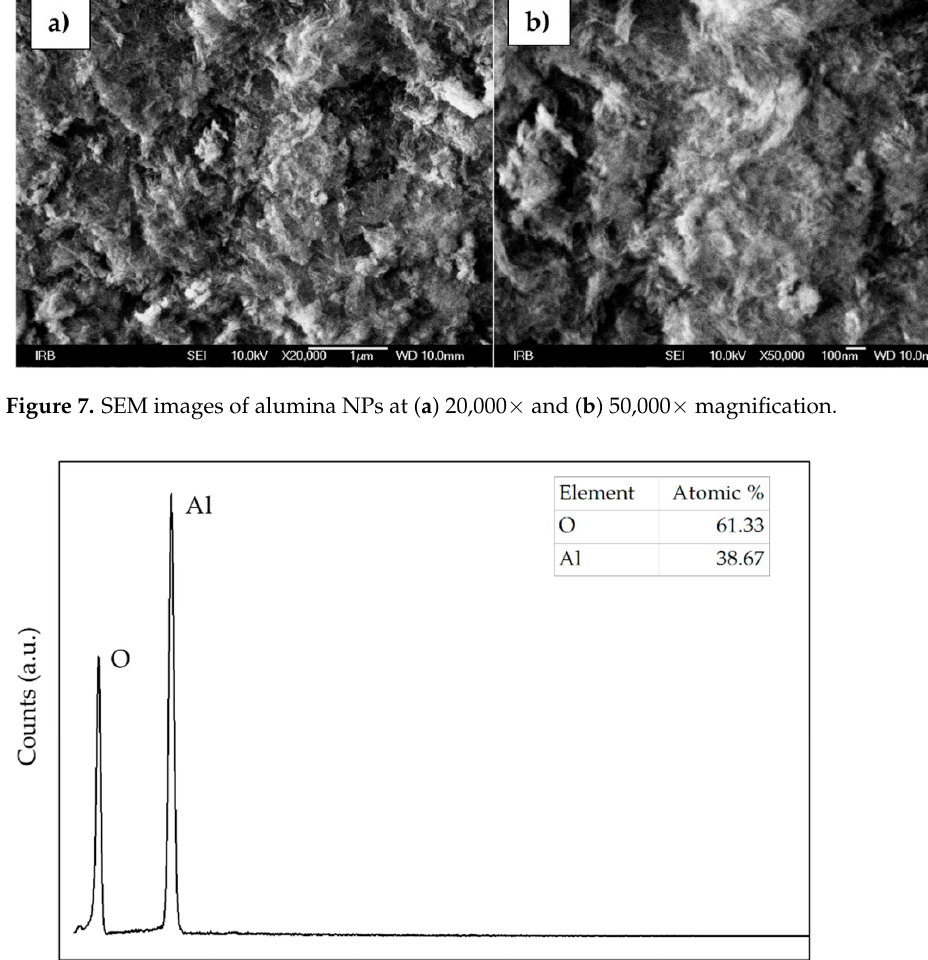
Figure 8. EDS pattern of alumina NPs. The results of the element analysis are shown in the inset.